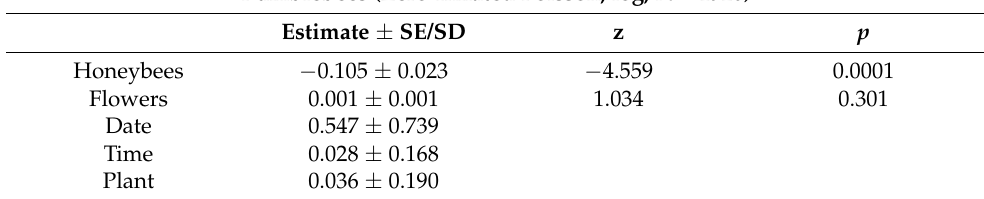
Table 1. Generalized linear mixed model evaluating the effects of the number of honeybees, Apis mellifera, per census and the number of open flowers per tree (fixed effect estimates ± SE) on the number of bumblebees, Bombus spp., per census. The error distribution family, the link function, the number of observations (N), as well as the variance ( ± SD) for date, time, and plant identity (random factors) are also